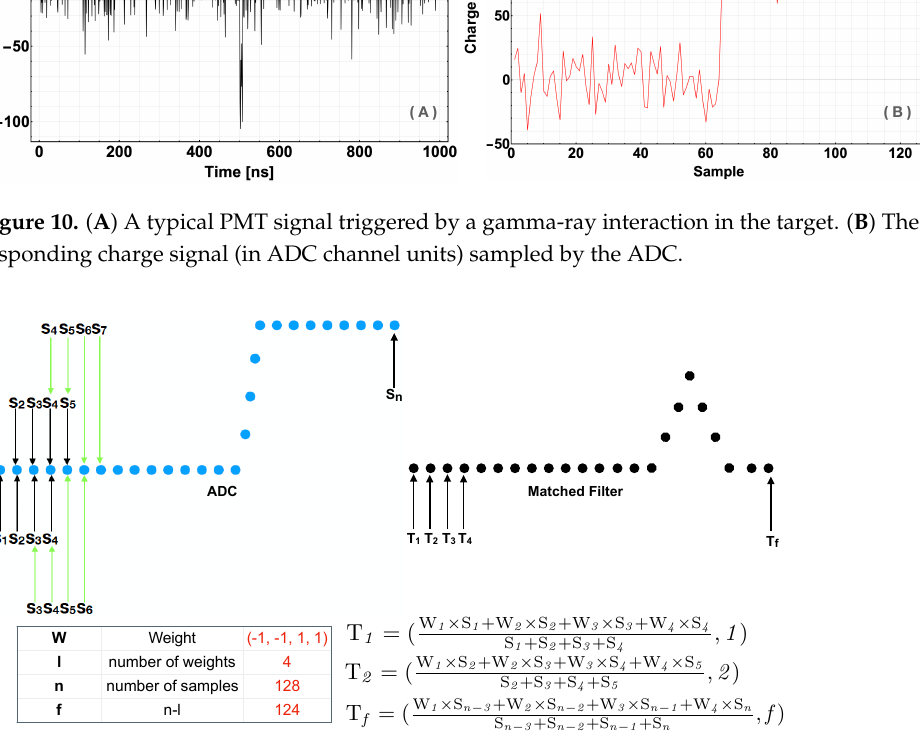
Figure 11. The photosensor integrated signal is sampled by a ADC (blue points). By combining the amplitude values of each sample S, the matched filter algorithm produces a new set of T values. The local maximum in T values is proportional to the energy released in the